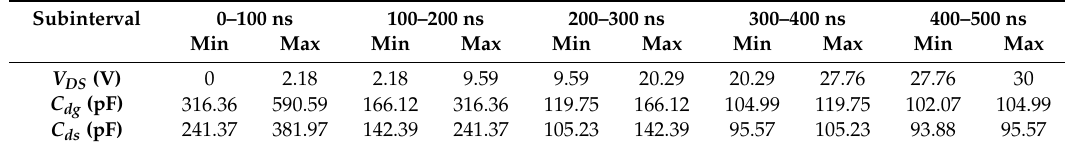
Table 2. Range of the nonlinear capacitances in each subinterval.